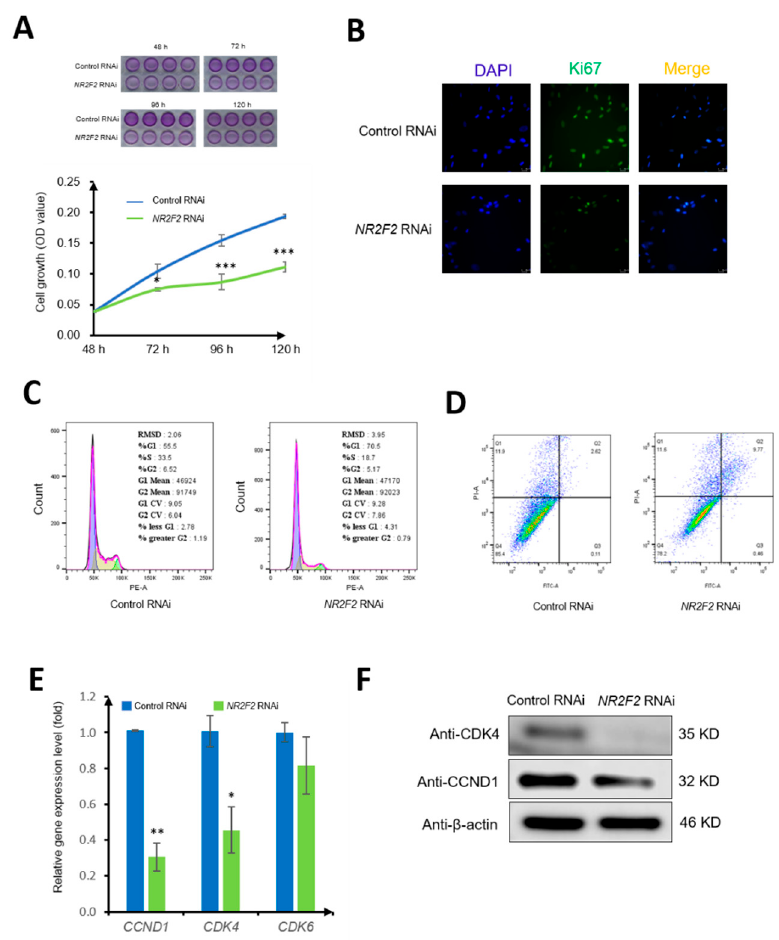
Figure 4. NR2F2 regulates WJ-MSC proliferation and cell cycle. ( A ) Growth curves of WJ-MSCs under control RNAi and NR2F2 RNAi conditions. Each time point in each row is n = 4. ( B ) Immuno- cytochemical staining for DAPI (blue) and Ki67 (green). ( C ) Flow cytometry to examine cell cycle changes. ( D ) Cell apoptosis was detected by flow cytometry. ( E ) qPCR results, relative expression levels of CCND1 , CDK4 , and CDK6 genes in control (control RNAi) and NR2F2 knockdown ( NR2F2 RNAi) groups. ( F ) Western Blot analysis of cyclin CCND1, CDK4 expression. * p ≤ 0.05, ** p ≤ 0.01, *** p ≤